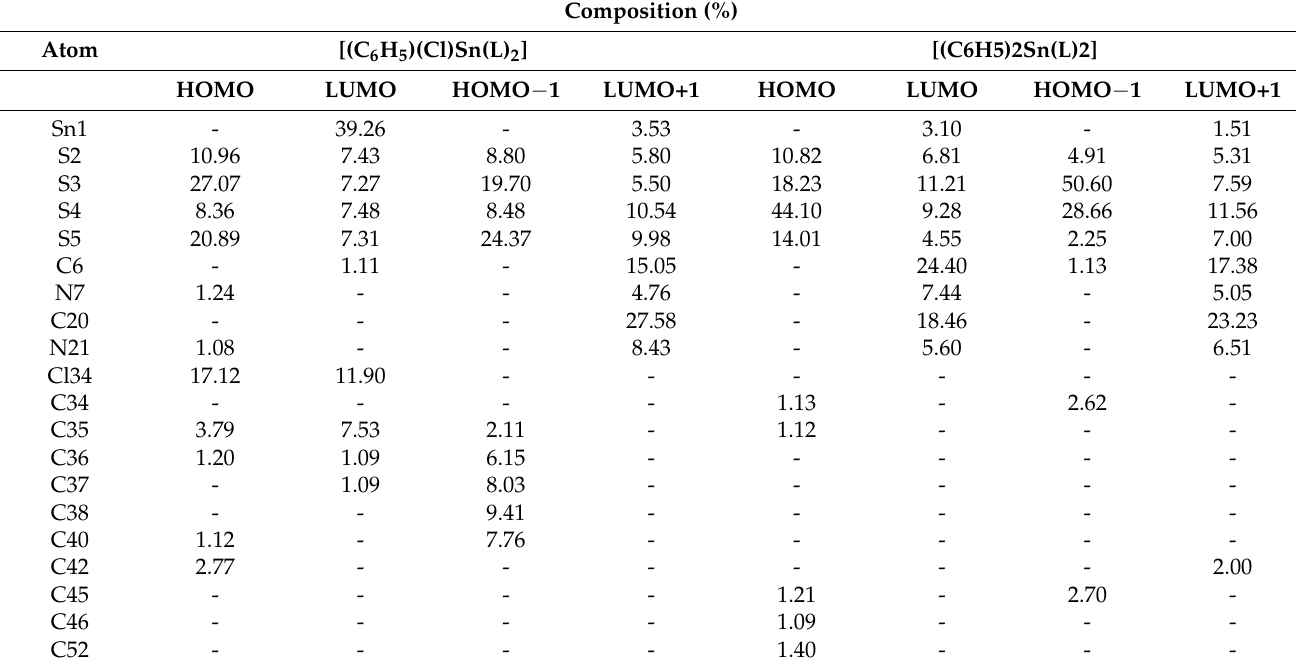
Atomic orbital compositions of the HOMO, LUMO, HOMO − 1, and LUMO+1 of [(C 6 H 5 )(Cl)Sn(L) 2 ] and [(C6H5)2Sn(L)2] (only contributions greater than or equal to 1.0 are